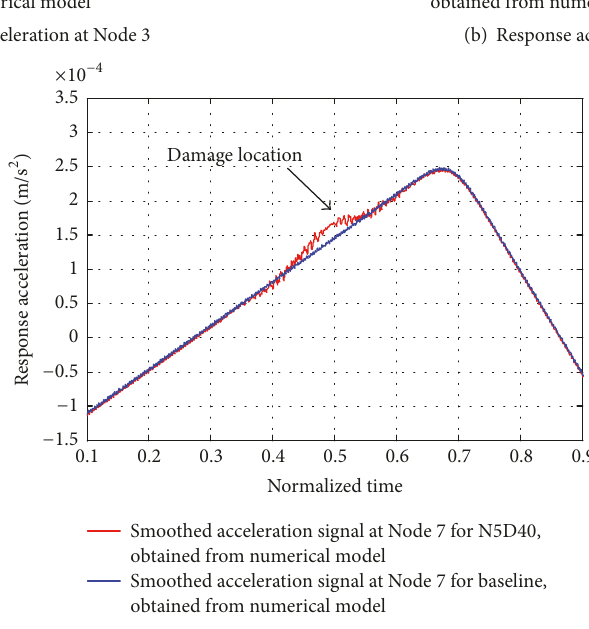
Figure 8: The smoothed acceleration signal for both damaged and undamaged beams (the damage occurred in the middle of the beam) at different locations along the beam. Blue color refers to the undamaged beam and orange color denotes the damaged beam: (a) signals from Node 3, (b) signals from Node 5, and (c) signals from Node 7.